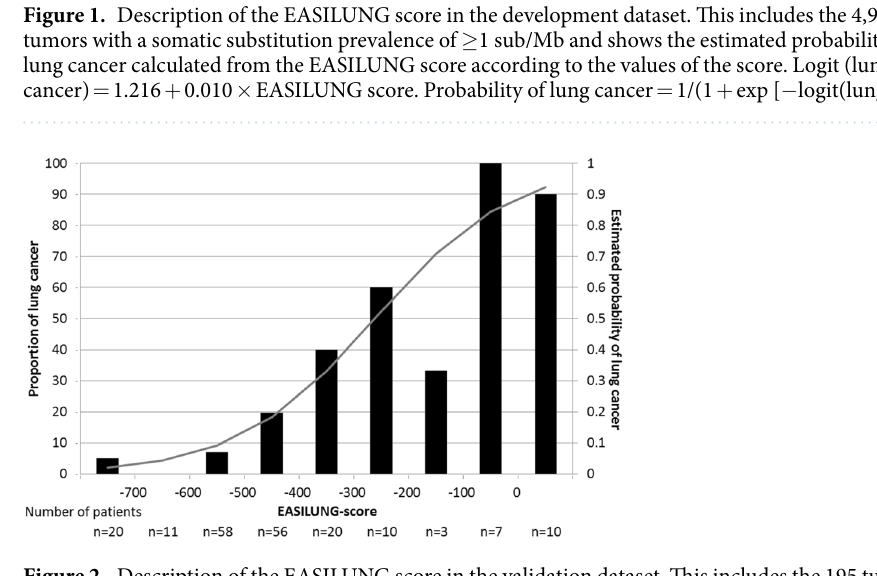
Figure 2. Description of the EASILUNG score in the validation dataset. This includes the 195 tumors with a somatic substitution prevalence of ≥ 1 sub/Mb and shows the estimated probability of lung cancer calculated from the EASILUNG signature according to the values of the score. Logit (lung cancer) = 2.094 + 0.008 × EASILUNG score. Probability of lung cancer = 1/(1 + exp [ − logit(lung